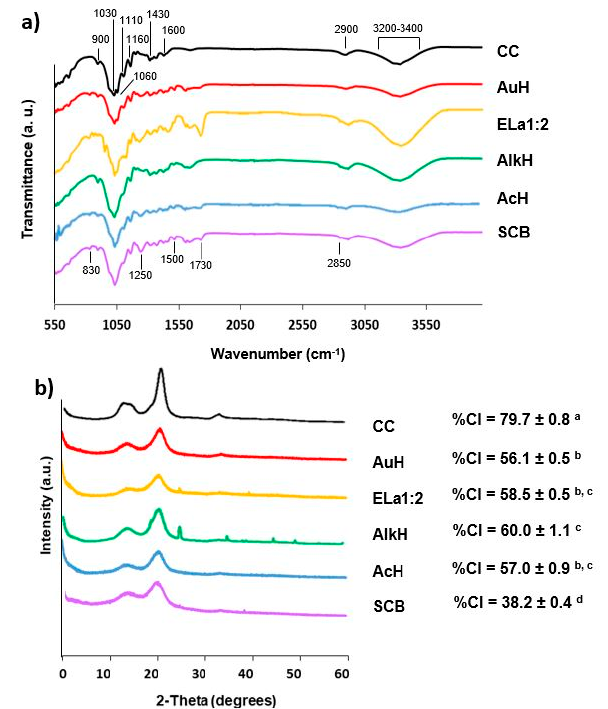
Figure 2. Structural characterization by ( a ) Fourier transform infrared spectrometry and ( b ) powder X-ray diffraction analysis of untreated sugarcane bagasse (SCB) and fractions extracted by: auto- hydrolysis (AuH), DES with choline chloride and lactic acid (ratio 1:2) (Ela1:2); alkaline hydrolysis (AlkH); and acid hydrolysis (AcH), in comparison with commercial cellulose (CC) used as control. CI averages followed by the same letters do not differ statistically by Tukey’s test ( p < 0.05).